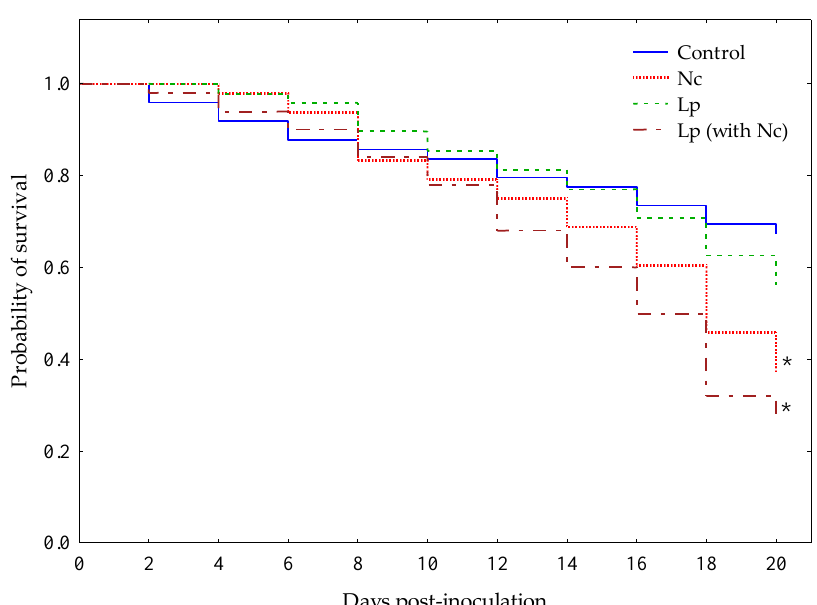
Figure 1. Kaplan-Meier survival curves distribution of worker bees in each experimental group during the 20 days. Each curve represents bees naturally infected with Lotmaria passim (Lp), healthy bees inoculated with N. ceranae (Nc), bees naturally infected with L. passim and inoculated with N. ceranae (Lp (with Nc) = mixed-species infection) and uninfected honey bees (control). Asterisks indicate significant di ff erences (* = p < 0.05) of pathogen-infected bees with respect to the control group, according to the Log-rank test with Holm-Bonferroni correction.